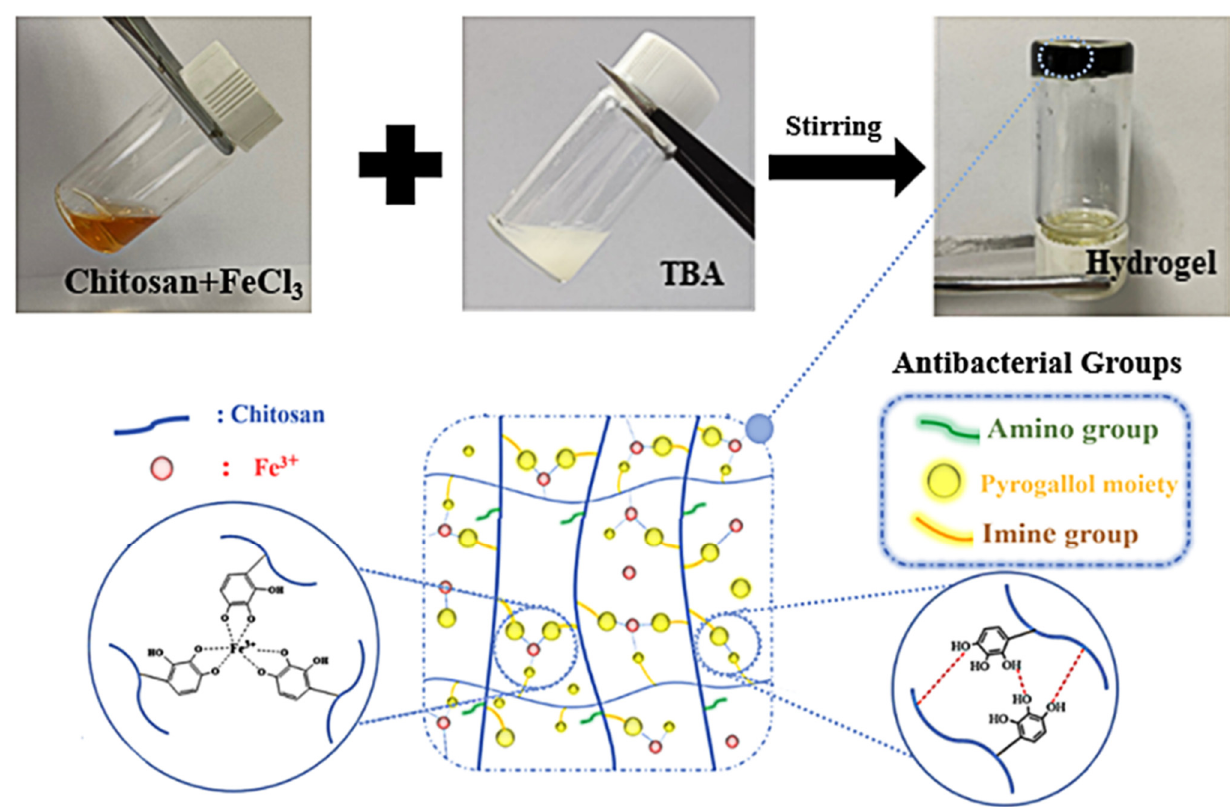
Figure 1. Schematic illustration of the formation of CS-TBA-Fe hydrogel by mixing CS-Fe and TBA solutions.